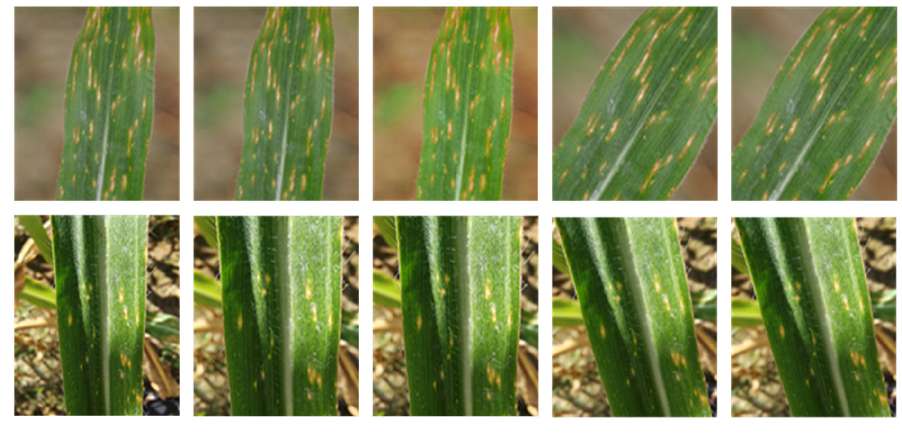
Figure 3. Example of data enhancement. Table 2. Data sets before and after image enhancement processing.